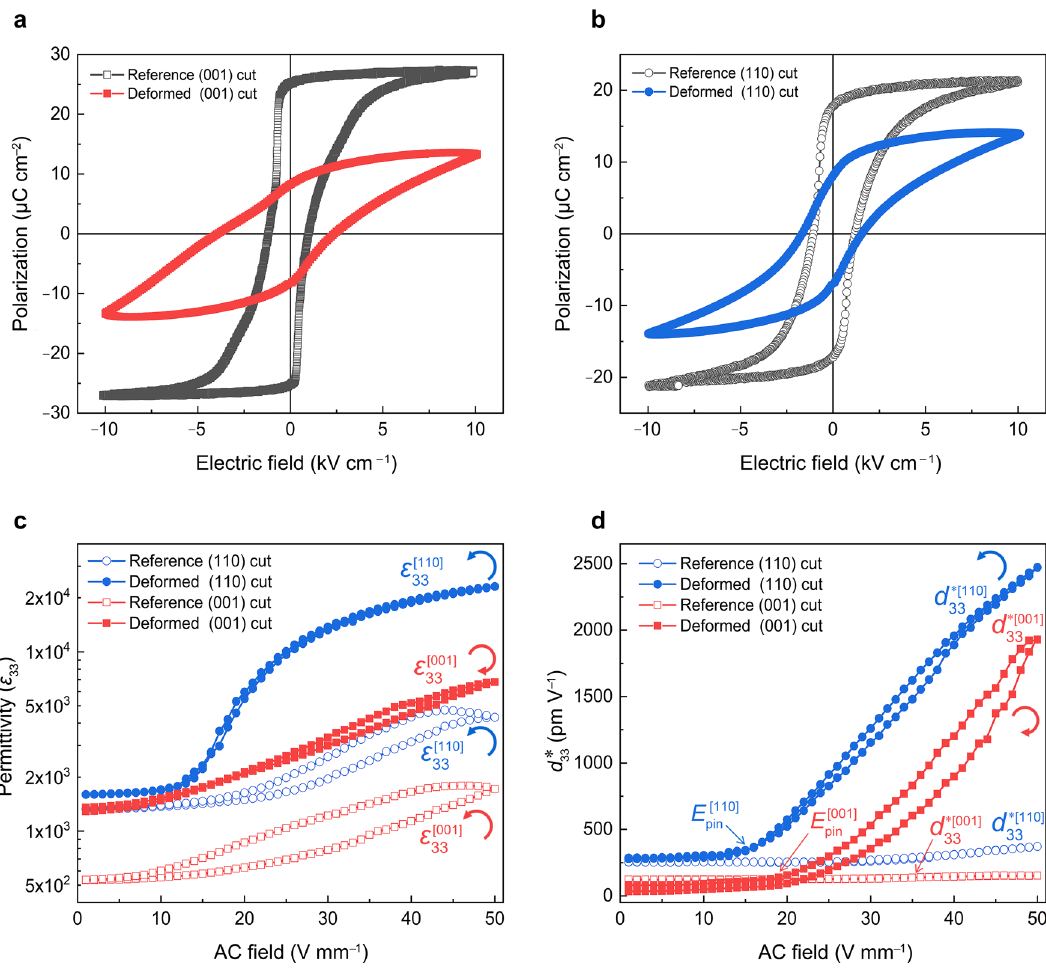
Fig. 2 | In fl uence of dislocations on electrical properties. a , b Polarization hys- teresis loops of reference and deformed (001)-and (110)-cut samples quanti fi ed at room temperature with a frequency of 1Hz. c Dielectric permittivity, ε 33 , and d corresponding converse piezoelectric coef fi cient, d 33 *, as a function of the amplitude of AC fi eld for reference and deformed (001)- and (110)-cut samples